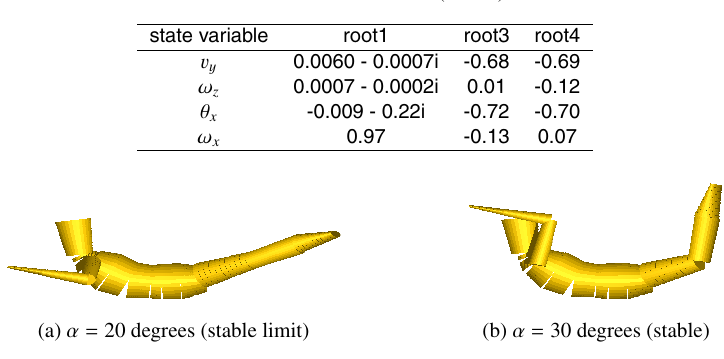
Fig. 10 Body positions when α = 20 degrees and 30